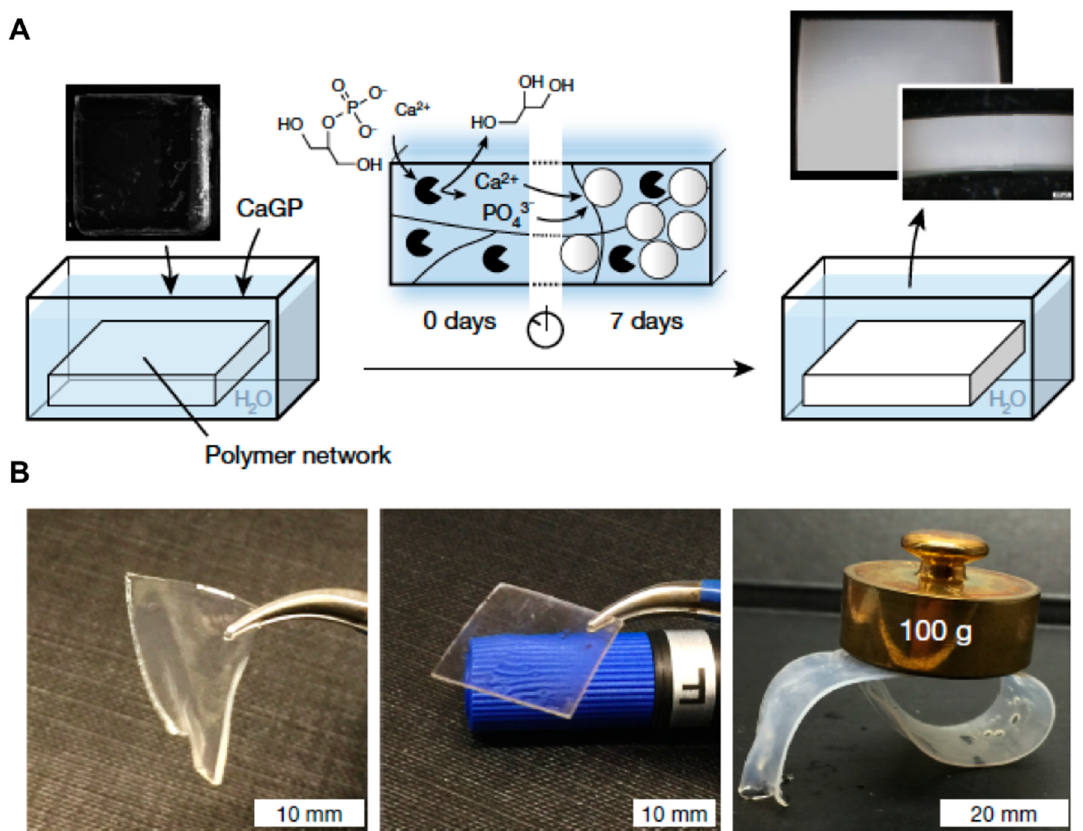
Figure 6. ( A ) Scheme of enzyme-induced bulk calcification of different polymer networks. Black pie shapes represent the enzyme, and the white circles represent the formed amorphous structures. The photographs show PDMA- l -TEG networks before ( left ) and after seven days ( right ) of mineralization. ( B ) Images of swollen PDMA- l -TEG network containing 10 wt.% EDPOA after seven days in water ( left ) or in calcification solution ( middle ). A circular-shaped swollen PDMA- l -TEG network containing 2 wt.% EDPOA and calcified for seven days, here loaded with a 100-g weight ( right ). Adapted with permission from Reference [50]. Copyright 2017 Nature Research.